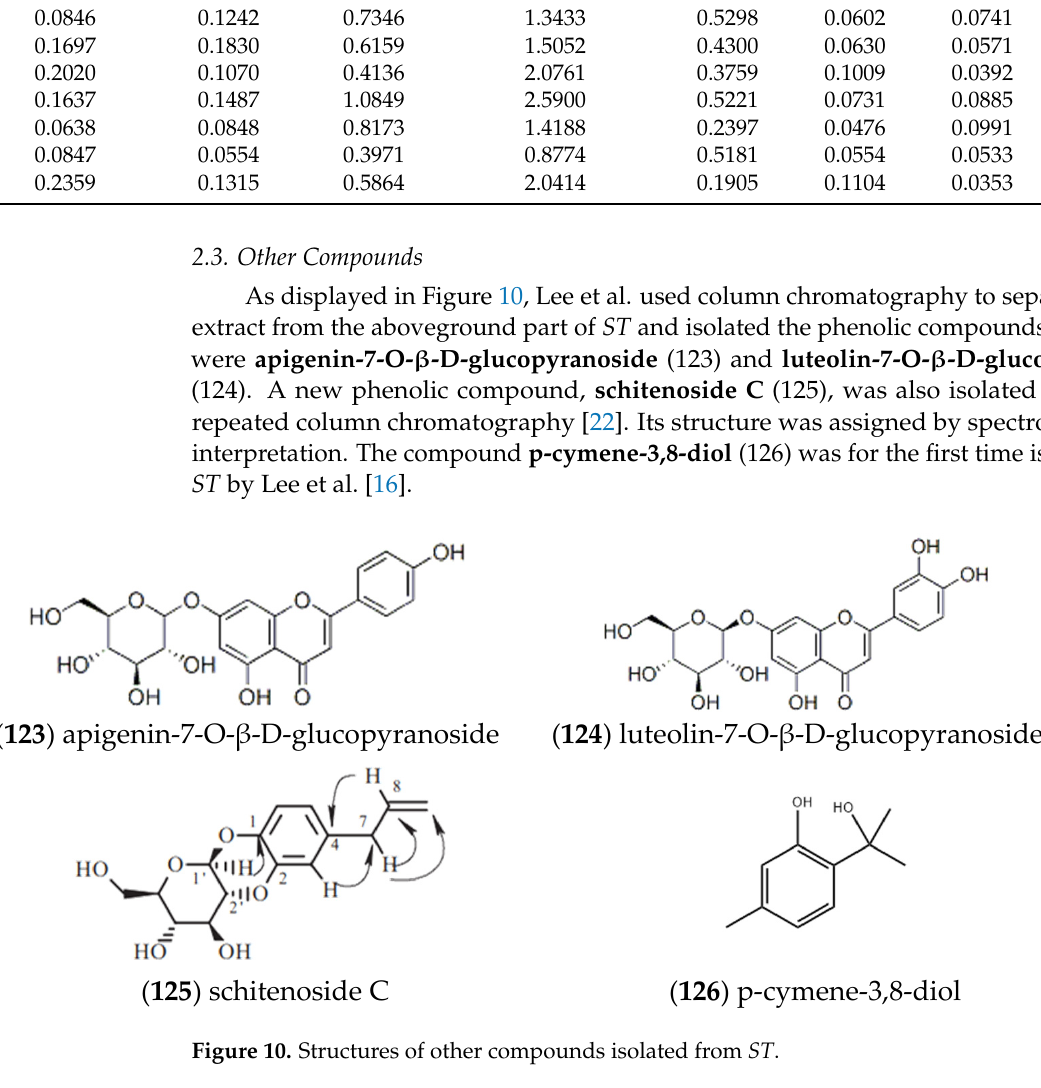
Table 2. The contents of eight components in ST from 13 different origins in China (mg/g) [21].